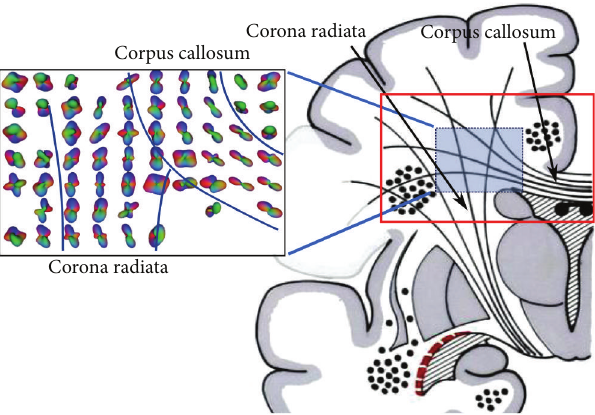
Figure 2: ROI used to illustrate the real data findings.